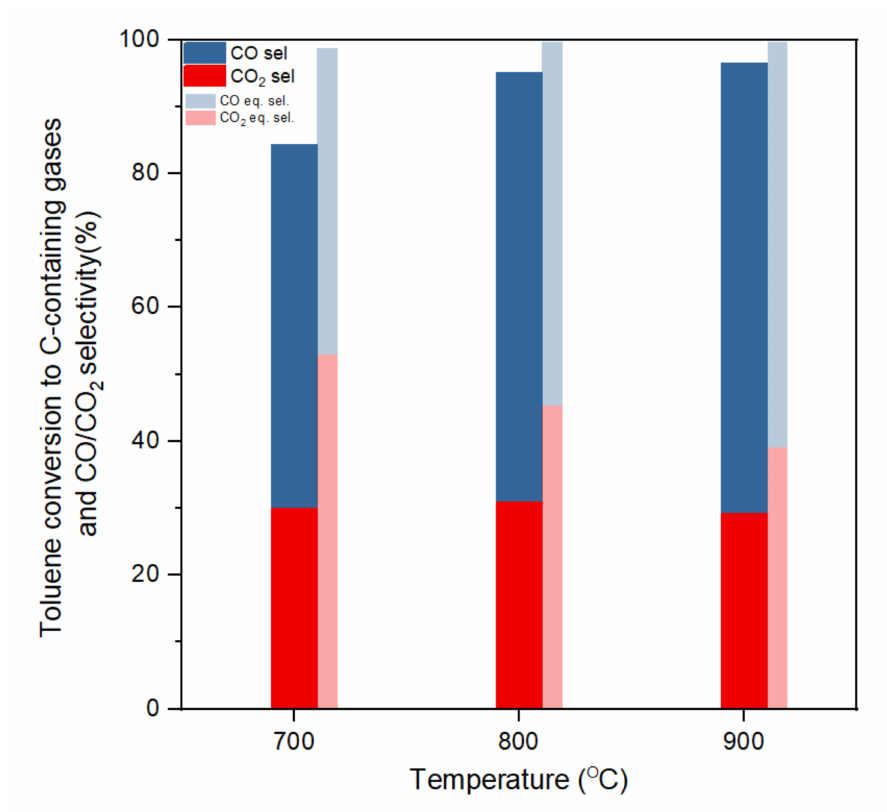
Figure 3. Toluene conversion to C-containing gases and CO / CO 2 selectivity at di ff erent temperatures (S / C:3, gas hourly space velocity (GHSV):61,200 h − 1